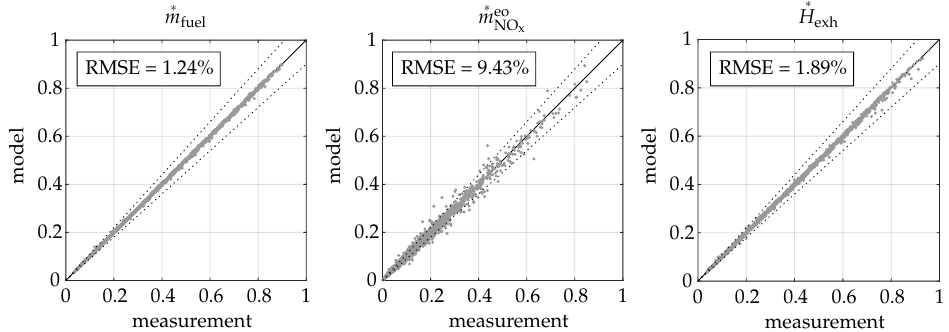
Figure 4. Validation of the GP models. The plots show the modeled values versus the measured values for the individual engine objectives. Each solid black line shows a perfect match, and the dotted lines show regions with ± 10%